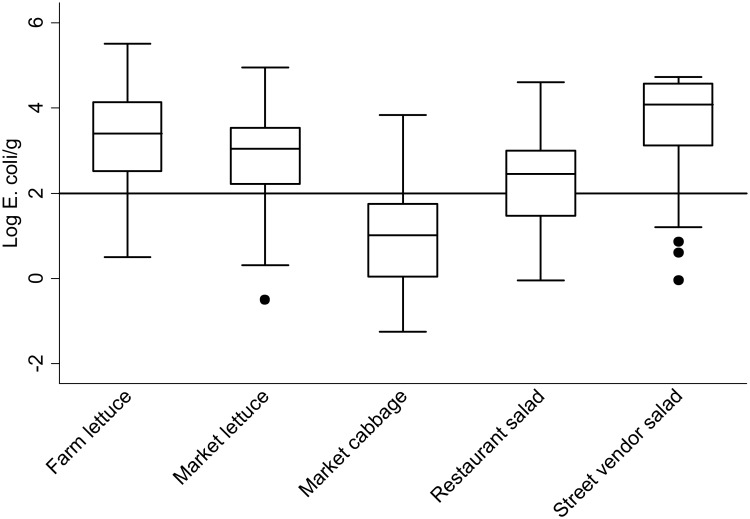

E. coli concentrations in raw produce and ready-to-eat salad at different entry points along the food chain.Solid horizontal line: limit of E. coli concentration classified as microbiologically satisfactory for consumption (% exceeding 2 Log E. coli/g—street vended salad, 90% (N = 59), farm lettuce, 88% (N = 159), market lettuce, 80% (N = 134), restaurants salad, 60% (N = 20), market cabbage, 18% (N = 129)). P-value calculated using Kruskal-Wallis test.